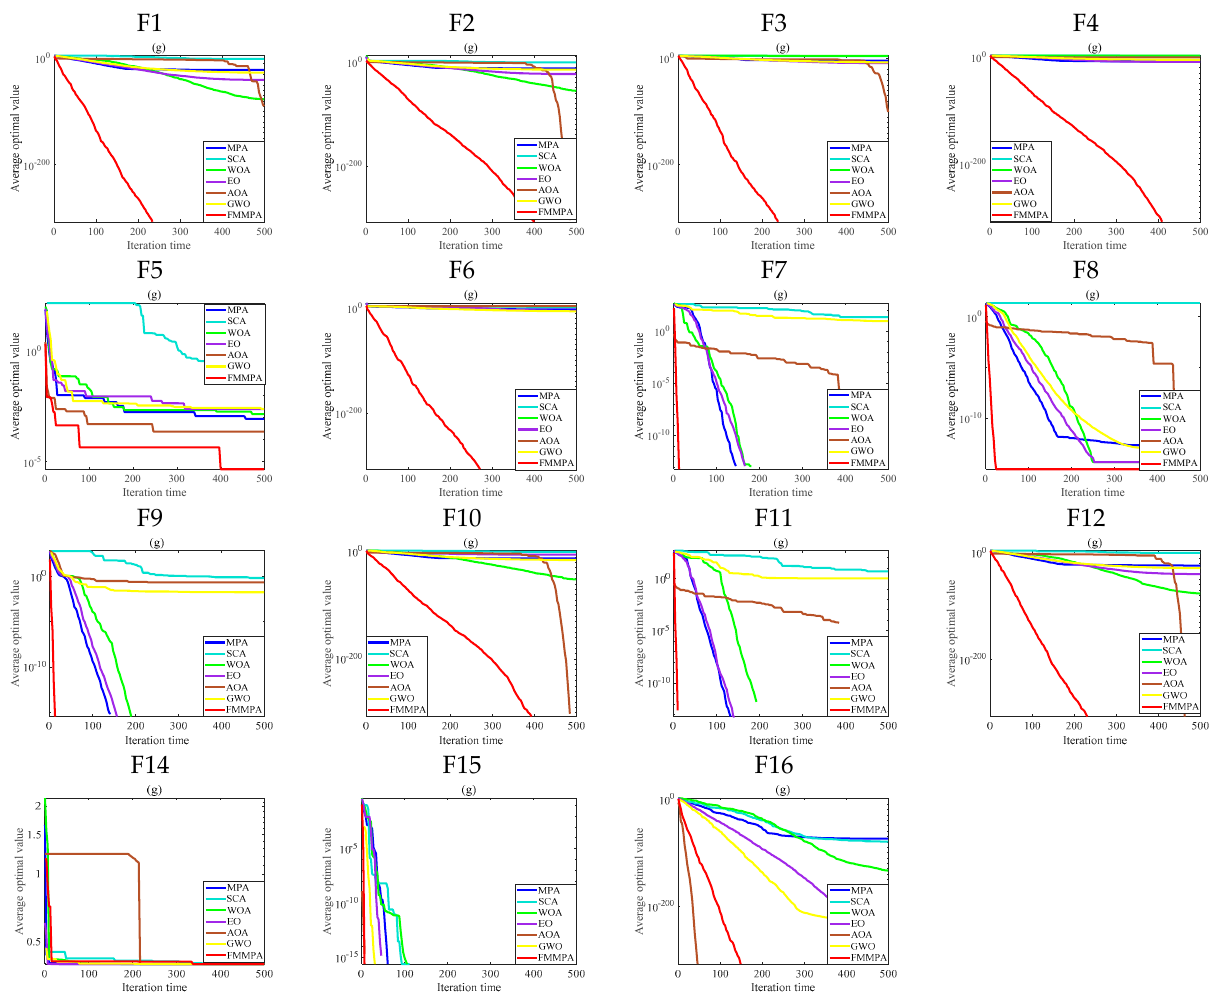
Figure 4. Convergence curves of FMMPA and other meta-heuristic algorithms on the benchmark test functions.